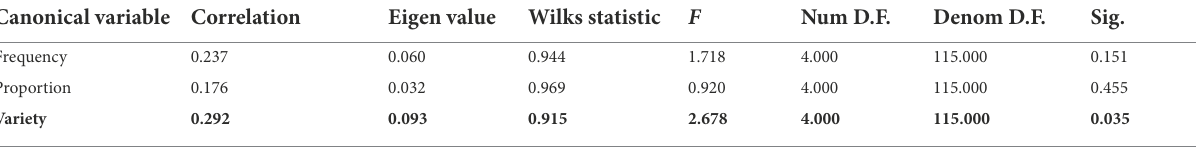
TABLE 7 Summary of the canonical correlation analyses: FSs and repair